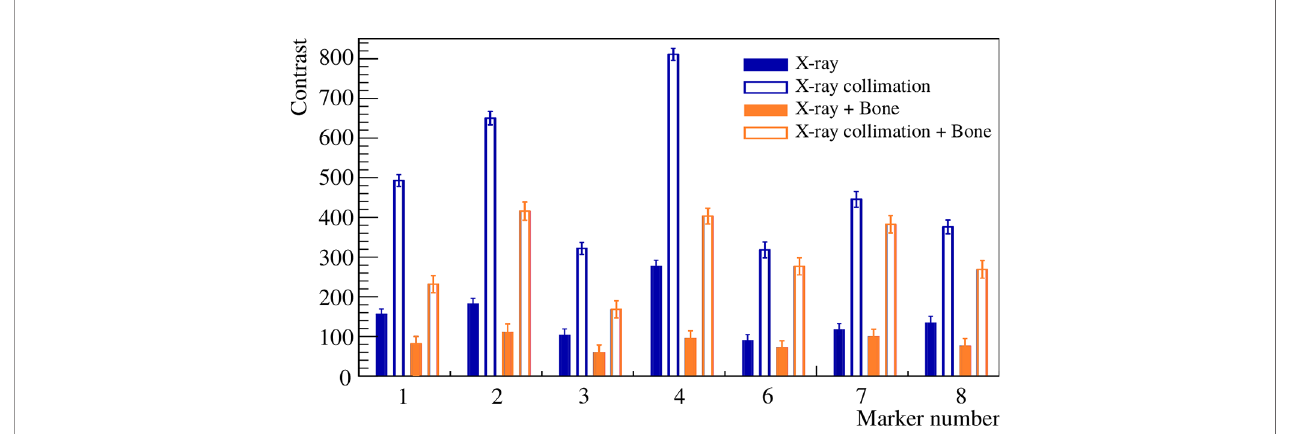
FIGURE 6 | Contrast of different fi ducial markers (listed in Table 1 ) from the X-ray imaging study for the different settings of Table